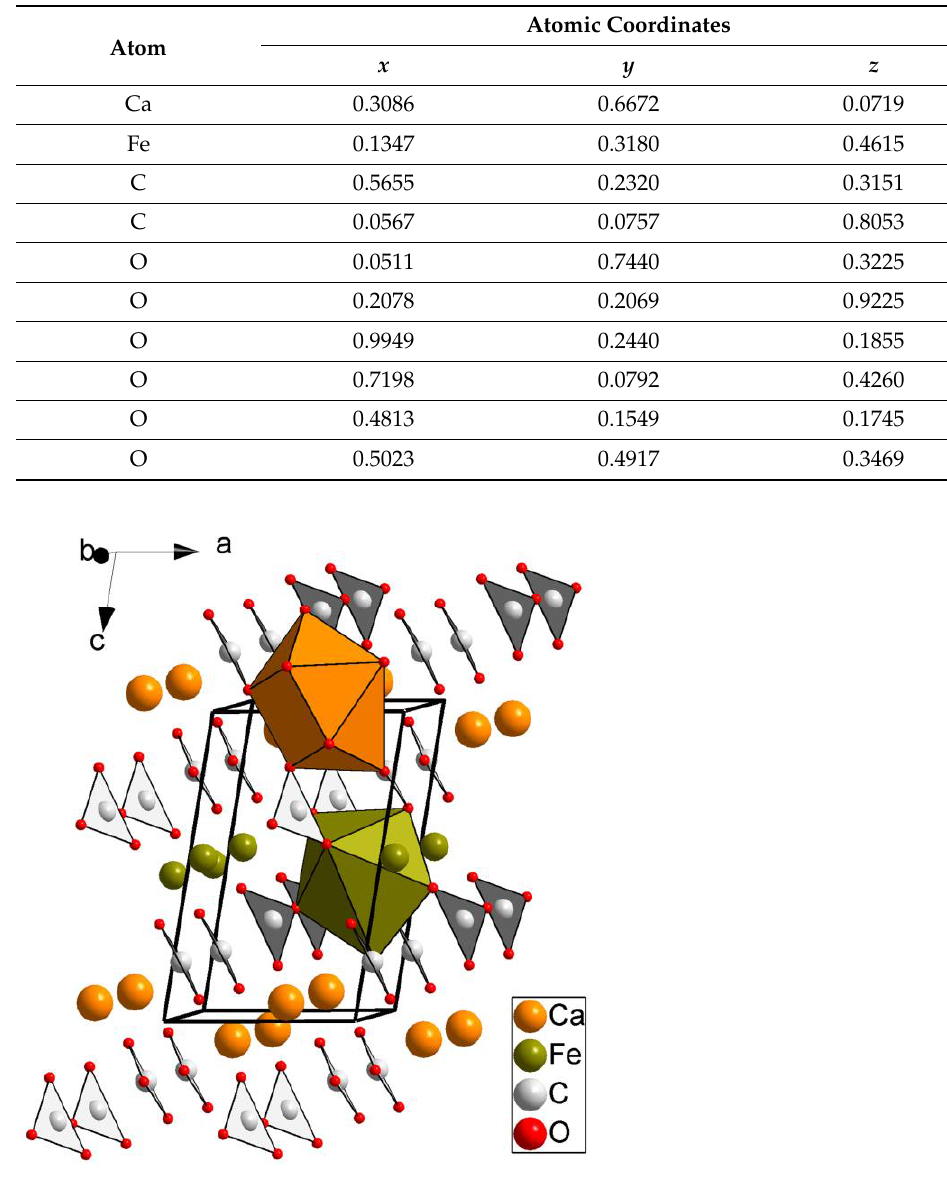
Figure 6. Structure of the calculated P - 1 ̅ “HP-ankerite” phase for pure CaFe(CO 3 ) 2 ankerite at 35.2 GPa. The red spheres represent the O atoms, whereas the light gray, orange, and green spheres correspond to C, Ca, and Fe atoms, respectively. The (CaO 9 ) and (FeO 7 ) polyhedra are also depicted.